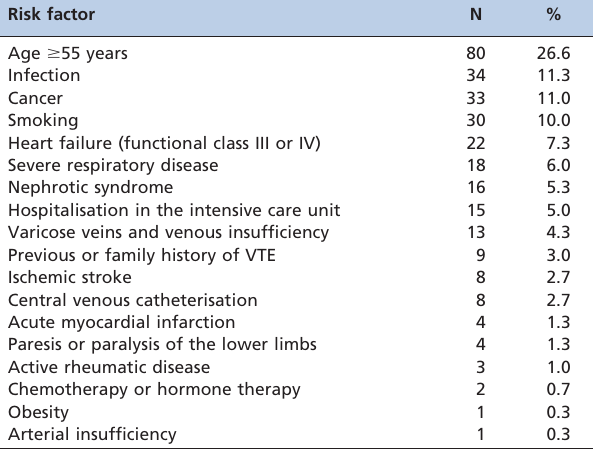
Table 1 - Characteristics of the hospitalised patients according to VTE risk. Characteristics Total With VTE Risk Number of patients, N (%)